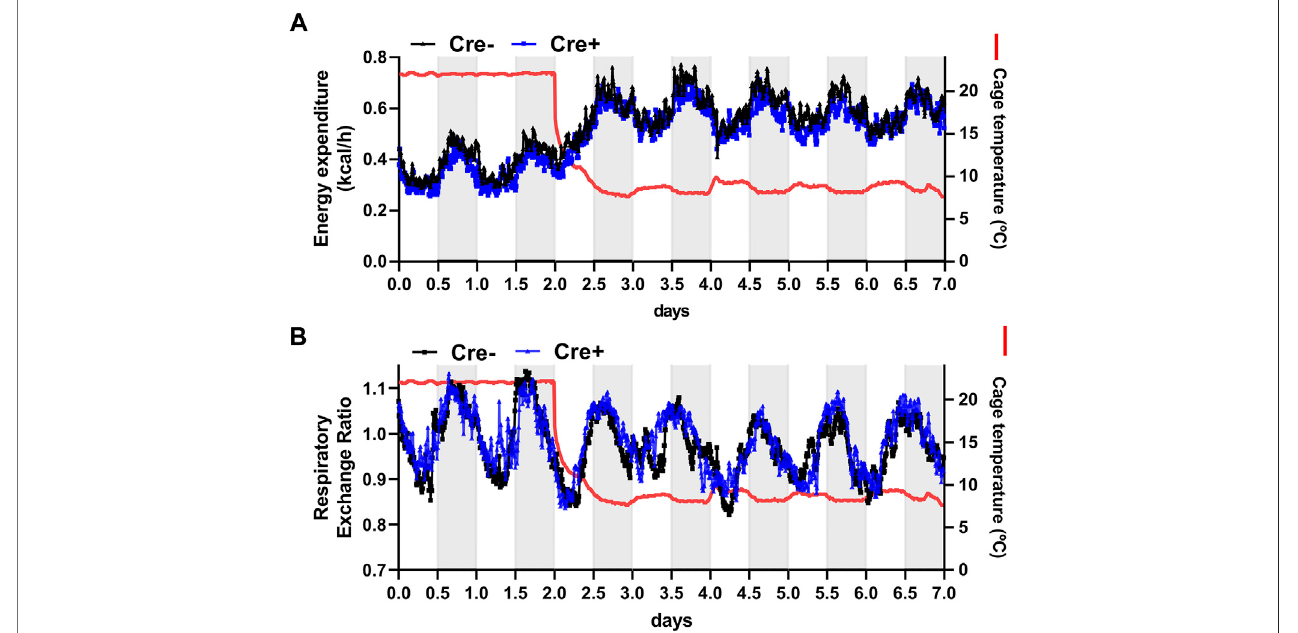
FIGURE 3 | Energy expenditure of endothelial cell-speci fi c LPL knockout mice. For indirect calorimetry analysis EndoLPLko (Cre+) and control (Cre-) mice fed a western-type diet were placed in a TSE phenomaster system. (A) Energy expenditure and (B) respiratory exchange ratio were determined by indirect calorimetry (n = 3 – 4). Results are presented as mean